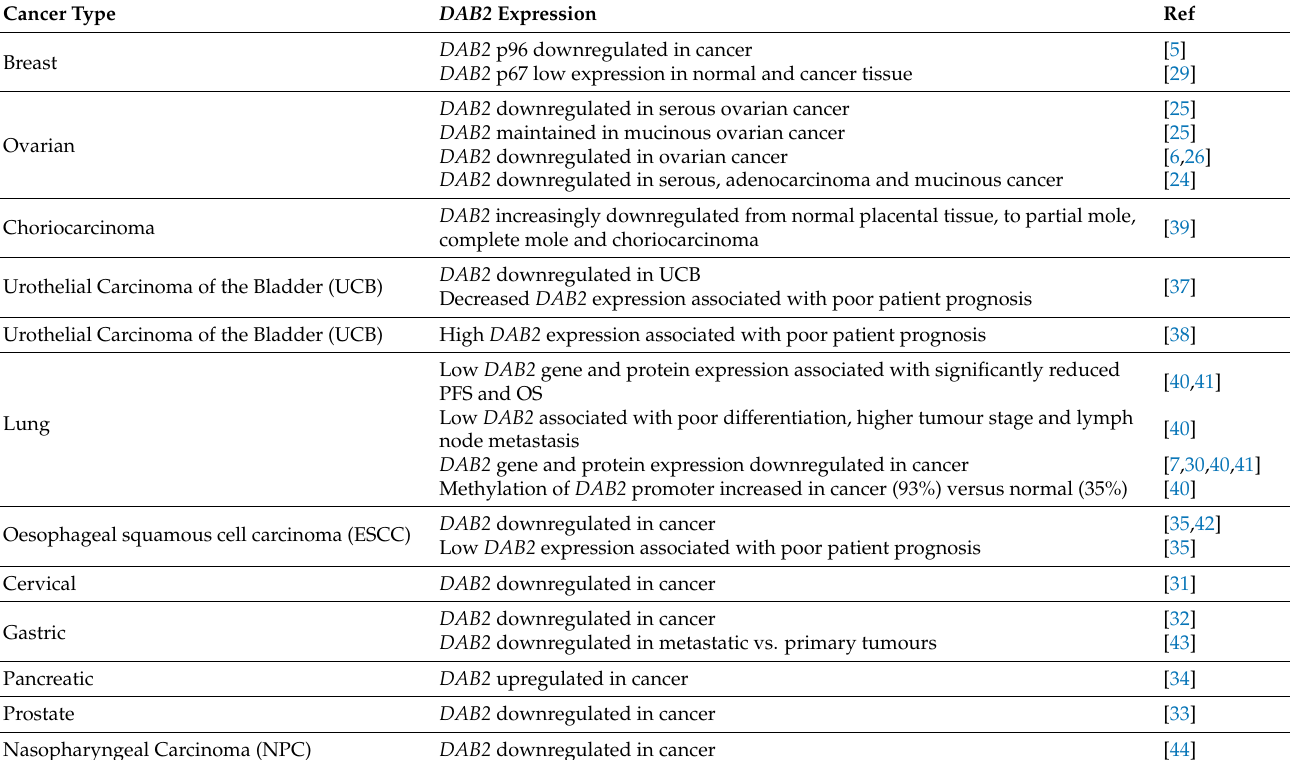
Table 1. Expression of DAB2 in different